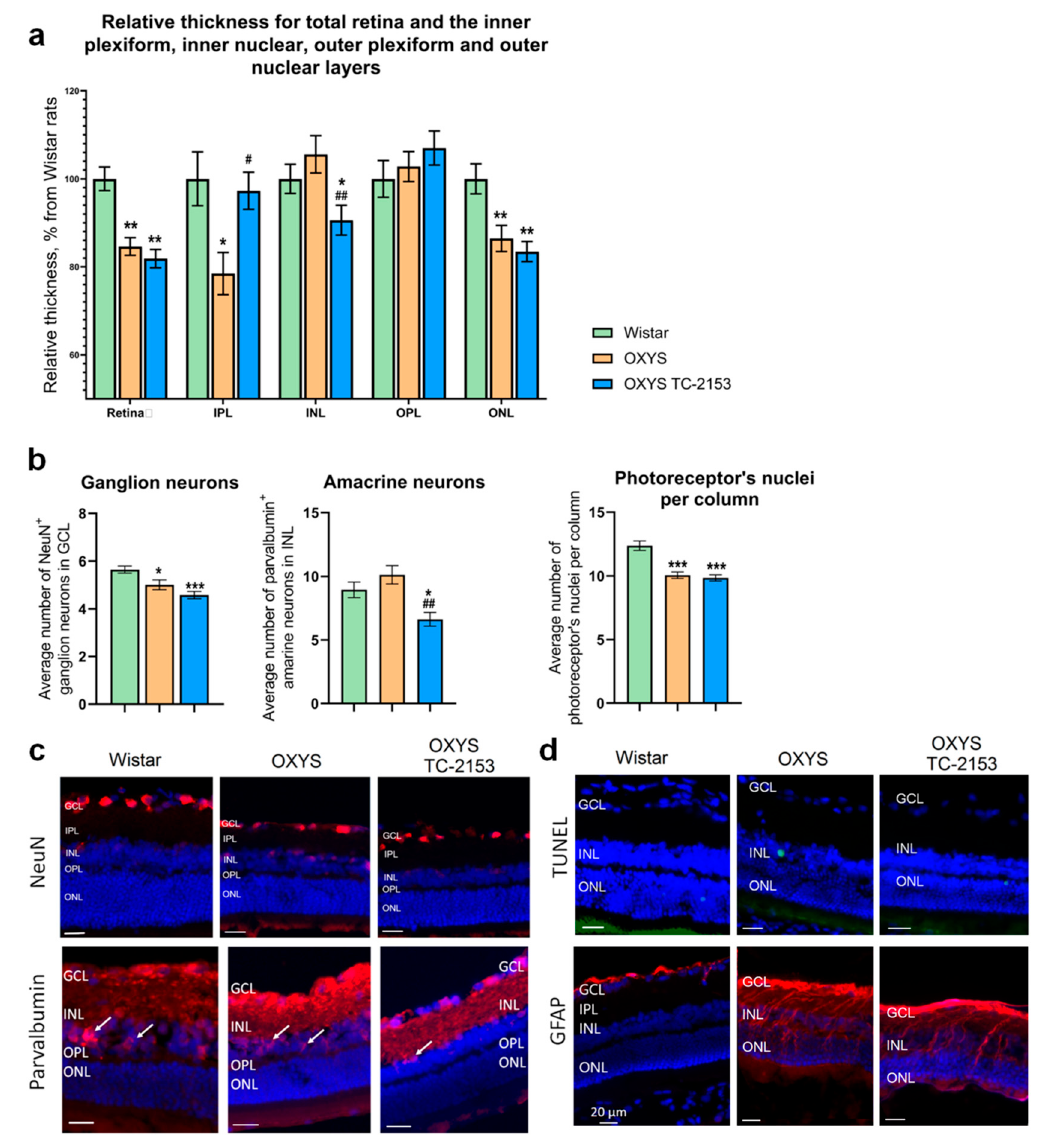
Figure 2. Effects of the STEP inhibitor (TC-2153) on retinal thickness metrics ( a ) and on the amounts of ganglion neurons, amacrine neurons, and photoreceptors ( b ) in 13-month-old OXYS rats. Data are presented as the mean ± SE, n = 4. Significant differences as compared to Wistar rats: * p < 0.05, ** p < 0.01, *** p < 0.001; OXYS rats as compared to TC-2153–treated OXYS rats: # p < 0.05, ## p < 0.01. ( c ) Representative images of retinas stained with antibodies against NeuN, parvalbumin, and GFAP and ( d ) apoptotic-cell detection by the TUNEL assay in Wistar and OXYS rats. Scale bar = 20 µm. Cell nuclei were stained with 4 ′ ,6-diamidino-2-phenylindole (DAPI). Arrows indicate amacrine neurons. GCL, ganglion cell layer; INL, inner nuclear layer; IPL, inner plexiform layer; and ONL, outer nuclear layer.